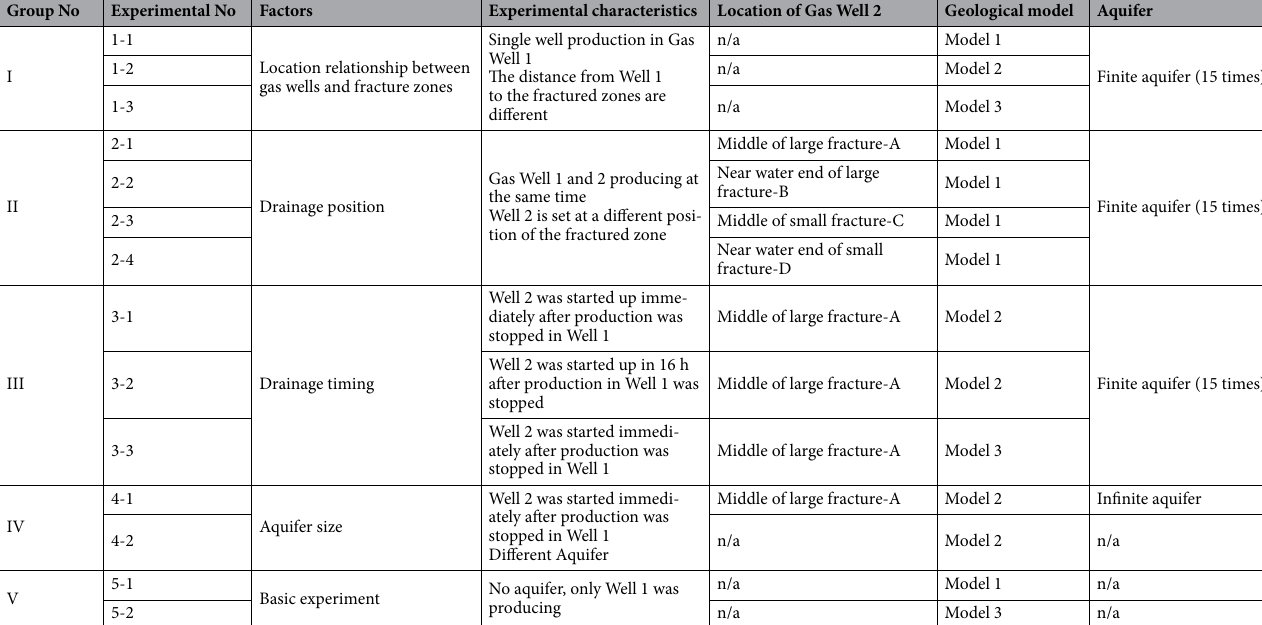
Table 2. Contents and parameters of different groups of